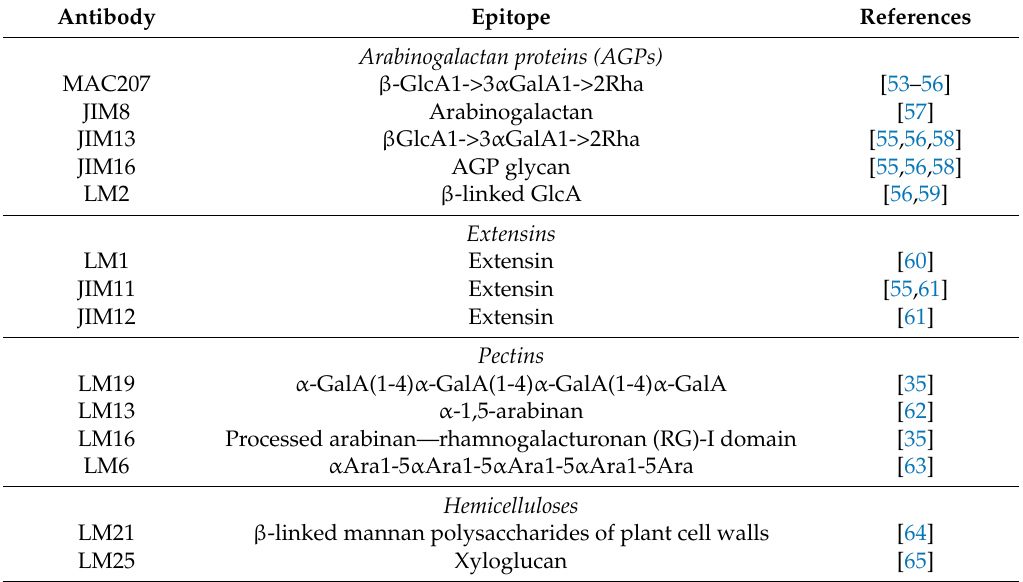
Table 1. The antibodies used for immunocytochemistry, the epitopes they recognise, and relevant references.